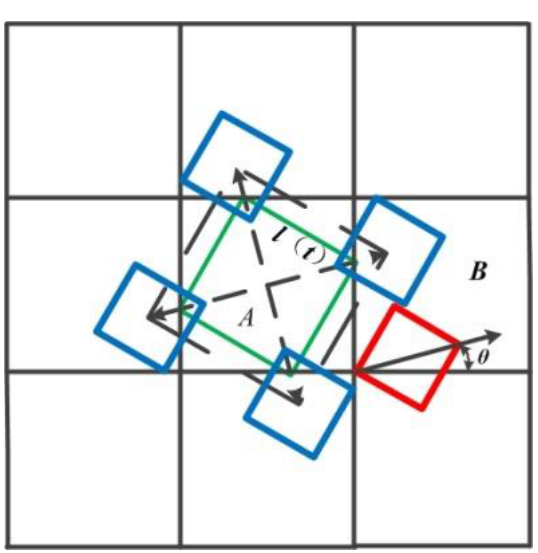
Figure 6. Diagram of modified eccentric square algorithm [27].